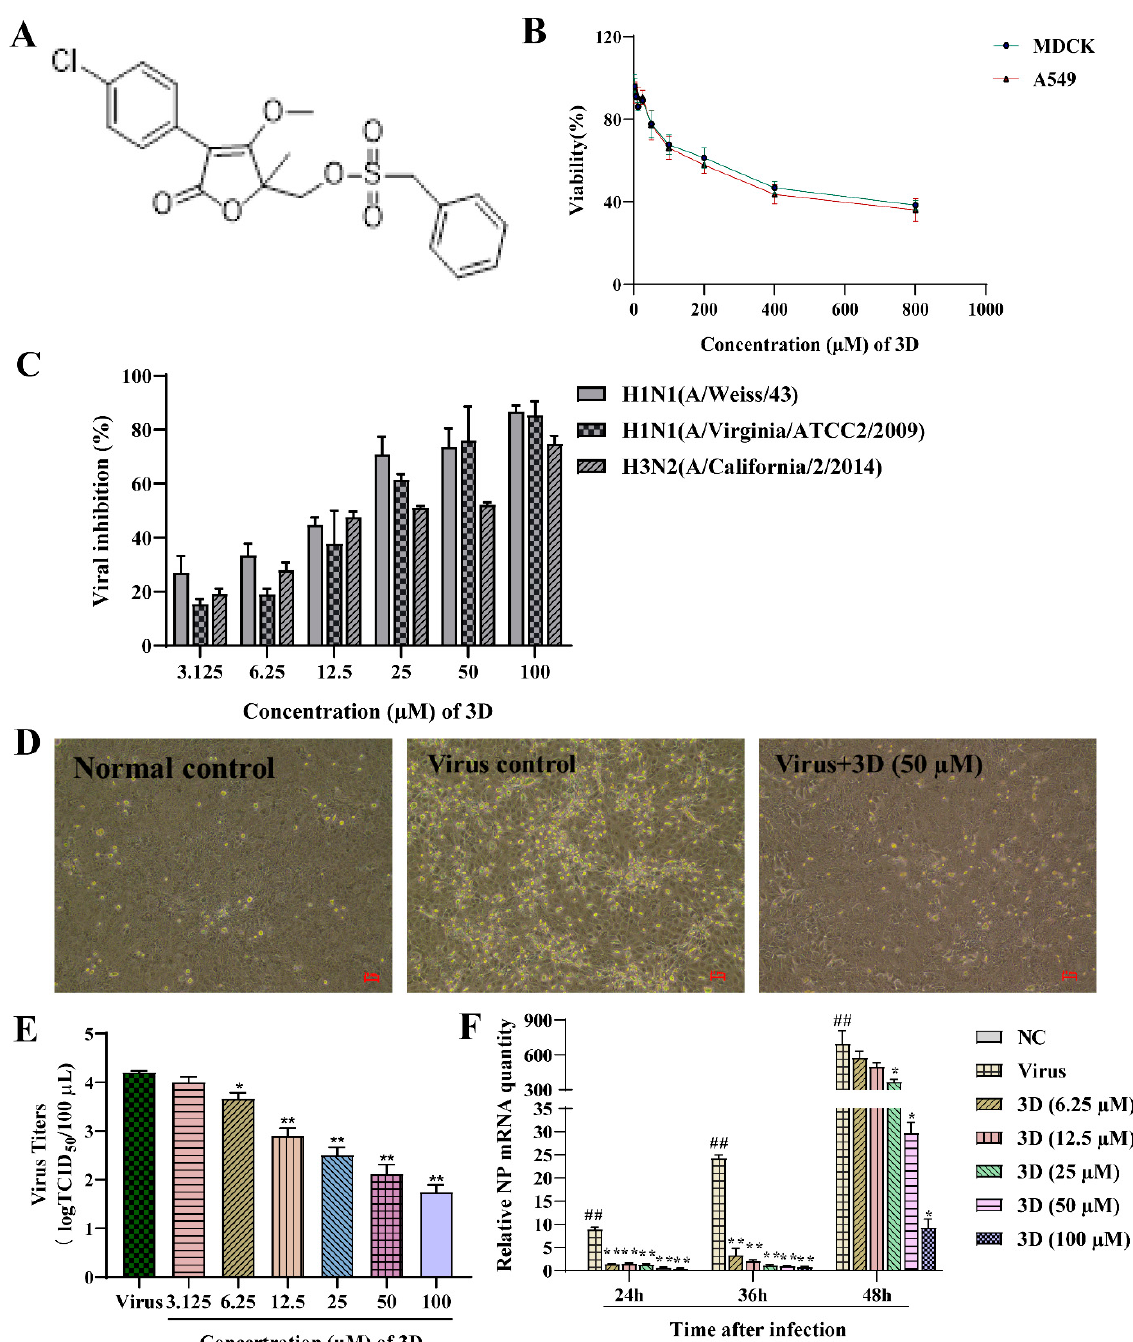
Figure 2. Inhibition of influenza virus infection by 3D, a butene lactone compound. ( A ) The chemical structure of 3D. ( B ) Cytotoxic effect of 3D on MDCK and A549 cells. Cells were treated with different concentrations of 3D for 72 h and cell viability was measured by 3-[4, 5-dimethylthiazol-2-yl]-2, 5-diphenyltetrazolium bromide (MTT) assay. ( C ) MDCK cells were infected with influenza A virus (A/Weiss/43 H1N1, A/Virginia/ATCC2/2009 H1N1 and A/California/2/2014 H3N2; 100 TCID 50 ) and then treated with indicated concentrations of 3D for 72 h. Then, MTT assay was performed to determine the viability of these cells. ( D ) MDCK cells were mock-infected or infected with A/Weiss/43 H1N1. The image was acquired after incubation with 3D (50 µ M) for 24 h (100 × ). ( E ) A549 cells infected with A/Weiss/43 H1N1 were treated with different concentrations of 3D for 72 h. Viral titers in the medium were analyzed by measuring the TCID50. ( F ) MDCK cells were infected with A/Weiss/43 H1N1 and treated with different concentrations of 3D. The expression of NP mRNA was detected by qRT-PCR at 24, 36, and 48 h post-infection ( x -axis). The data are shown as the mean ± SD. ( ## p < 0.01 as compared with the normal control; * p < 0.05, ** p < 0.01 compared with the virus